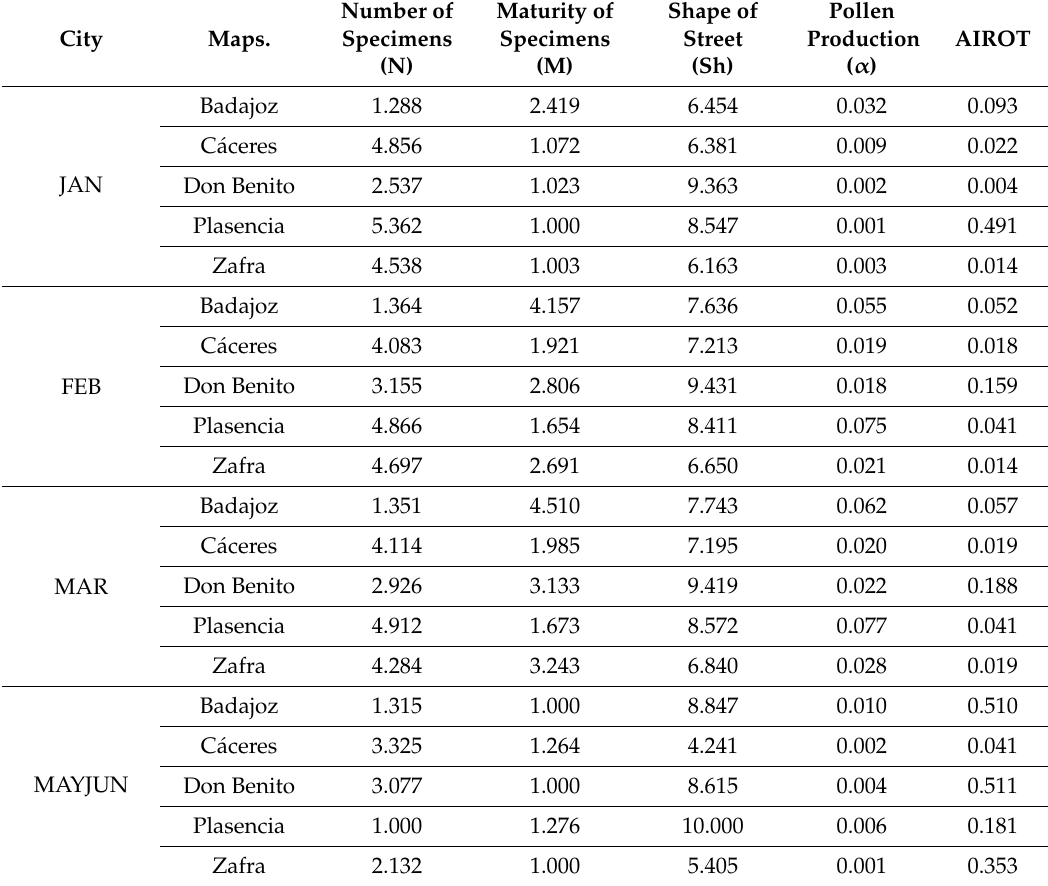
Table 4. Average values of some parameters (M, N and Sh) used in Index to create Risk maps for Ornamental Trees (AIROT) (normalized values from 0 to 10) and values for the α and AIROT (from 0 to 1).